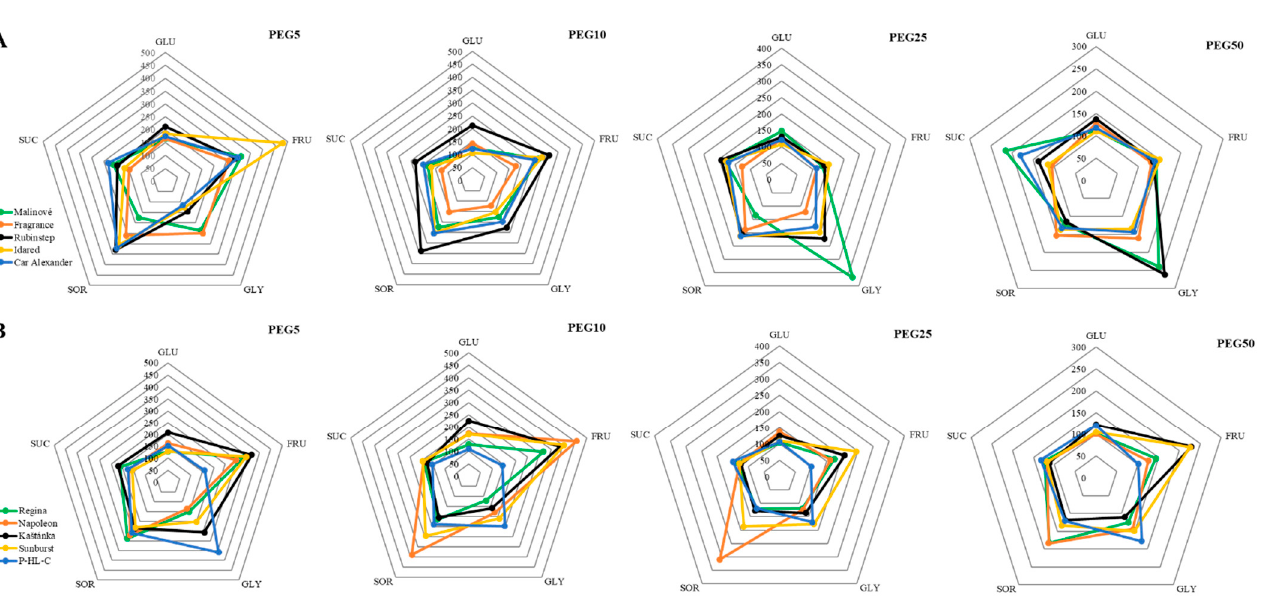
Figure 5. Effect of PEG ‐ 6000 concentration on scavenging activity of DPPH radical (%) for in vitro culture of apple ( left ) and cherry ( right ) cultivars. Error bars represent standard deviation (SD). Values within column, followed by the same letter(s), are not significantly different according to Tukey’s test ( p < 0.05). A simultaneous increase in activities of monitored enzymes with increasing PEG con ‐ centration was noticed in tested apple and cherry cultivars (Figure 6). The highest values of CAT activity in both PEG0 and PEG treated plants were observed in the cultivar “Car Alexander”. Higher values of enzymatic activity in PEG0 plants were also found in the case of cultivars “Fragrance” and “Rubinstep”. However, at the same time, the smallest